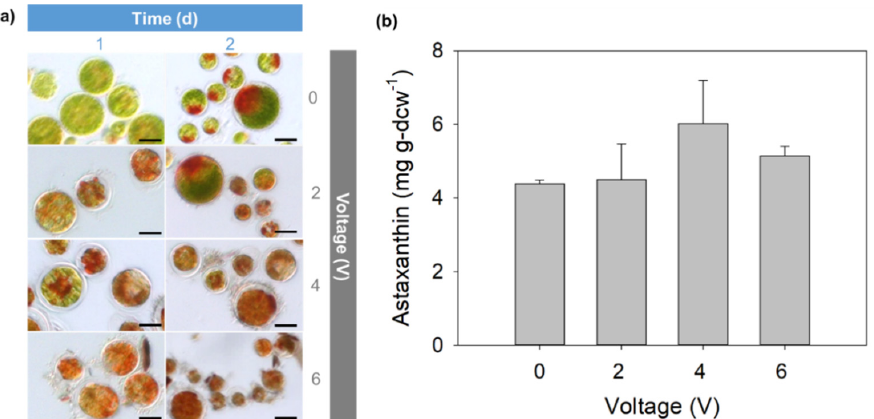
Figure 4. Effects of voltage intensity on the optical morphology ( a ) and astaxanthin content ( b ) of Haematococcus pluvialis cells in the anodic chamber of the two-chamber electrochemical reactor. The cellular astaxanthin levels were analyzed after the 2 day treatment. Scale bars in the optical images represent 15 μ m.